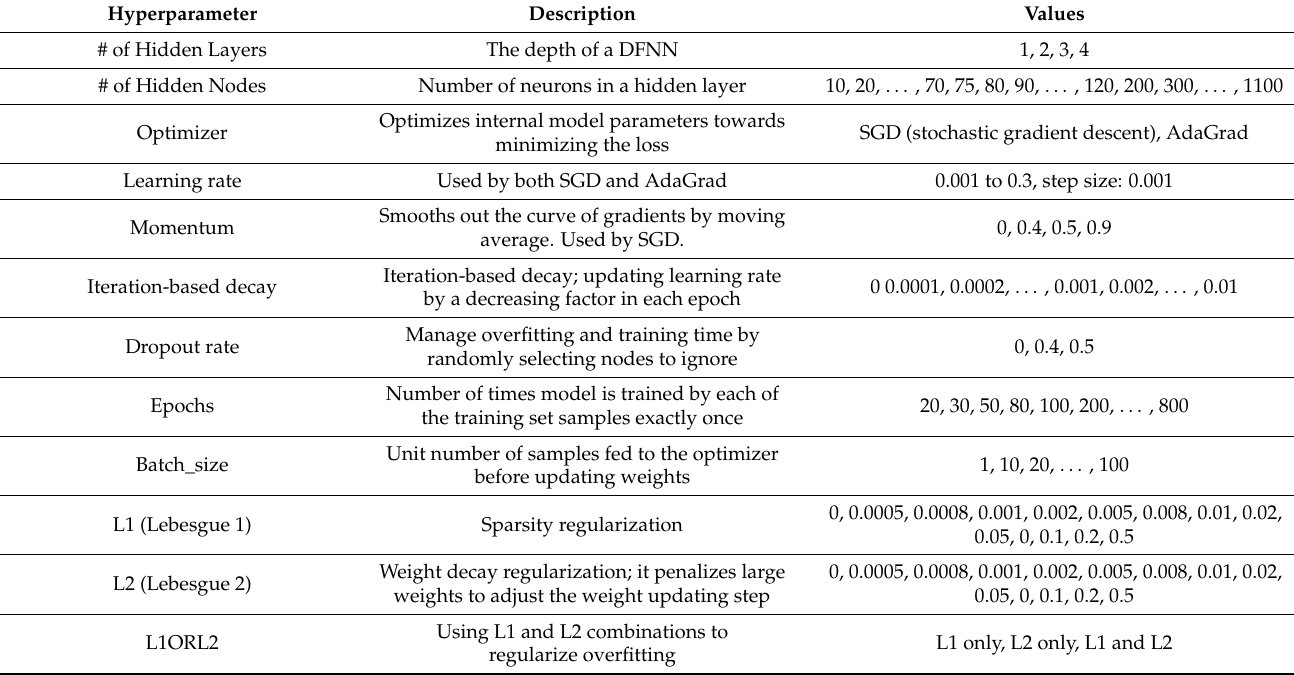
Table 2. Description of the DFNN (deep feedforward neural network) hyperparameters and their values tested (note: # represents the word “number” in this